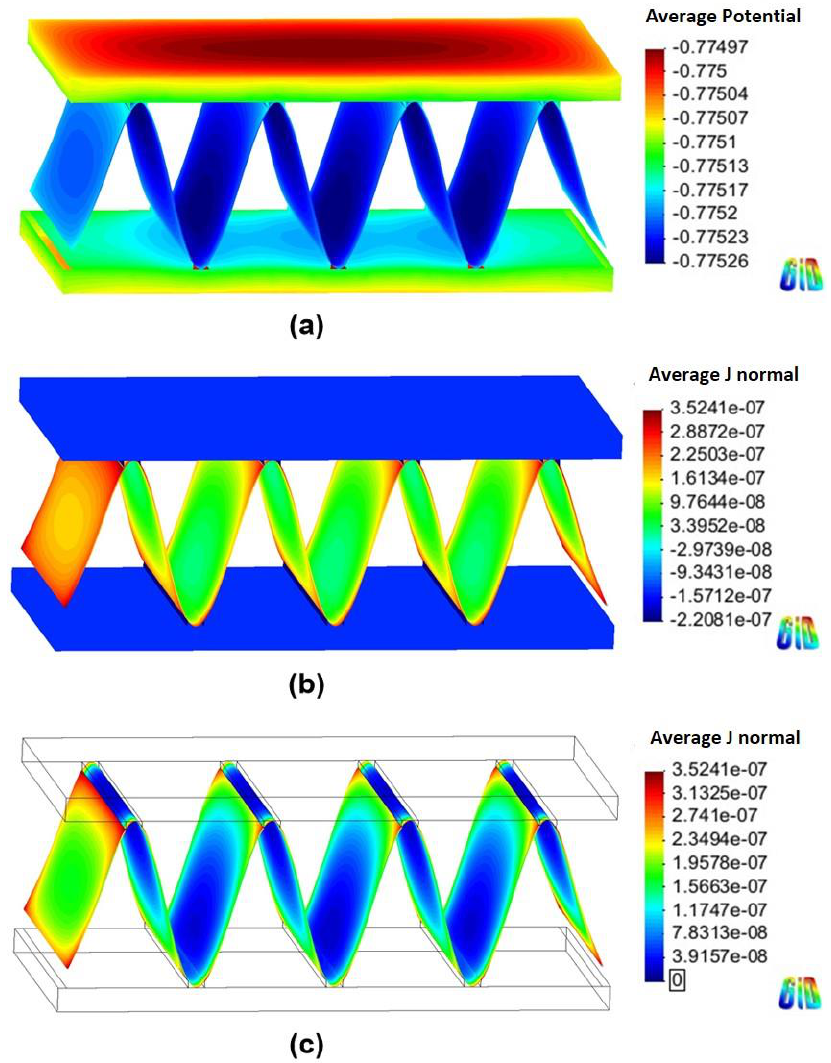
Figure 6. Simulation results of the Al fin-tube heat exchanger assembled with a cathodic joint in high-conductivity electrolyte: ( a ) potential, ( b ) current density, and ( c ) anodic current density distribution.